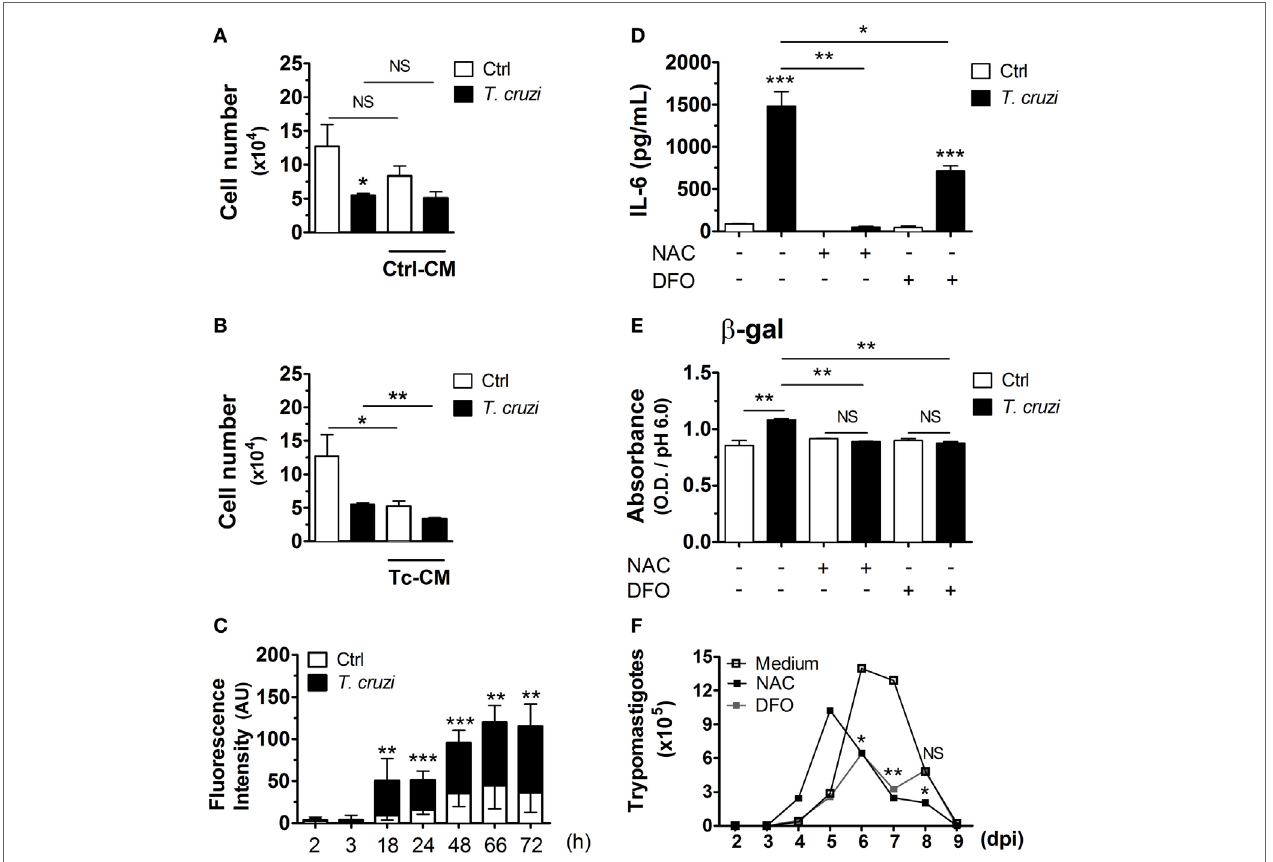
FigUre 4 | Trypanosoma cruzi -induced ROS is a potent inducer of SASP in NIH-3T3 fibroblasts. NIH-3T3 fibroblasts were infected overnight with culture-derived T. cruzi trypomastigotes (MOI 5:1). After washing step to eliminate extracellular parasites, cultures were treated with (a) 50% supernatants from non-infected or (B) T. cruzi -infected cultures (conditioned medium) plus 50% of fresh medium. After 3 days, the number of T. cruzi -infected or non-infected fibroblasts were quantified by optical microscopy. Dead cells were evaluated by Trypan blue exclusion assay. (c–e) NIH-3T3 fibroblasts were loaded with the probe DCFH-DA, washed and infected with T. cruzi concomitantly with addition of antioxidants NAC (20 mM) and DFO (40 µM) during infection period (MOI 5:1). After overnight infection, cultures were washed to eliminate extracellular parasites and cultured for additional 3 days. (c) Assessment of ROS accumulation after T. cruzi infection in NIH-3T3 fibroblasts by fluorescence. Results indicate arbitrary units of fluorescence. (D) Evaluation of IL-6 in culture supernatant by ELISA. (e) Evaluation of soluble SA- β -gal activity at pH 6.0 in cell lysates. (F) Assessment of extracellular parasitic load (trypomastigote forms) in culture supernatants over 10 days. Data are presented as the mean ± SE of at least six biological replicates and analyzed by unpaired, two-tailed Student’s t -test (c,D) , and non-parametric Mann–Whitney test (e) . For (a,B,F) , data were log-transformed and analyzed by Student’s t -test. * p < 0.05; ** p < 0.01; *** p < 0.001; NS, statistically not significant, p > 0.05. Data are representative of at least three independent experiments with similar results. Abbreviations: MOI, multiplicity of infection; Ctrl, control; ROS, reactive oxygen species; NAC, N -acetylcysteine; DFO, deferoxamine; DCFH-DA, dichloro-dihydro-fluorescein diacetate; h, hours; ROS, reactive oxygen species; SASP, senescence- associated secretory phenotype; SA- β -gal, senescence-associated β